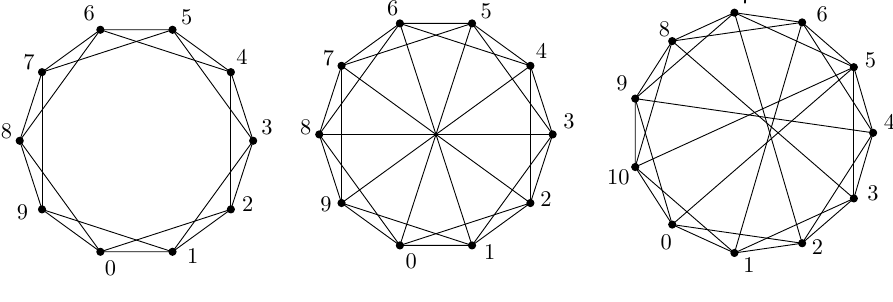
Fig. 4: The Harary graphs H 4 , 10 , H 5 , 10 and H 5 , 11